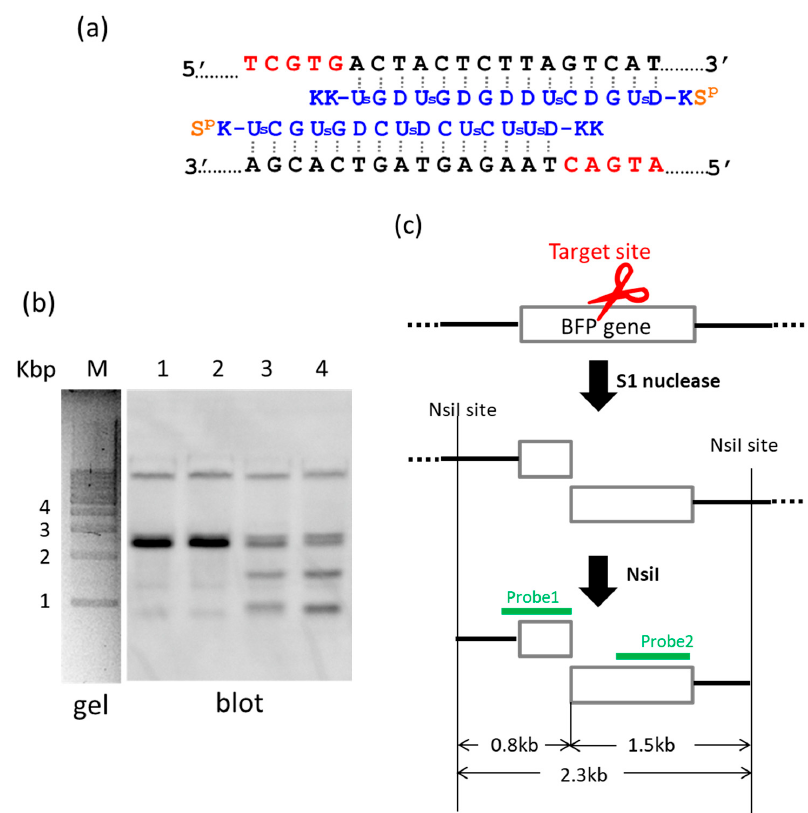
Figure 2. Clipping of internal fragments from human genome using the S1 nuclease–pcPNA combination. The genome was first treated with artificial DNA cutter (the combination of two pcPNA strands and S1 nuclease), and then digested by a restriction enzyme NsiI. The products were analyzed by Southern blotting. ( a ) The sequences of pcPNAs targeting the BFP gene which is stably integrated into the human genome; and ( b ) Southern blotting. Lane 1, treatment of the genome with S1 nuclease in the absence of the pcPNAs; lane 2, incubation of the genome with the pcPNAs in the absence of S1 nuclease; lane 3, the scission by using the S1 nuclease–pcPNA combination at 37 °C for 1 h; lane 4, the scission by the combination at 50 °C for 30 min; lane M, 1 kbp markers. As presented in ( c ), the dual scission by the artificial DNA cutter and NsiI should provide two fragments of 0.8 and 1.5 kbp, which were detected in the lower parts of the gels in lanes 3 and 4 in ( b ).